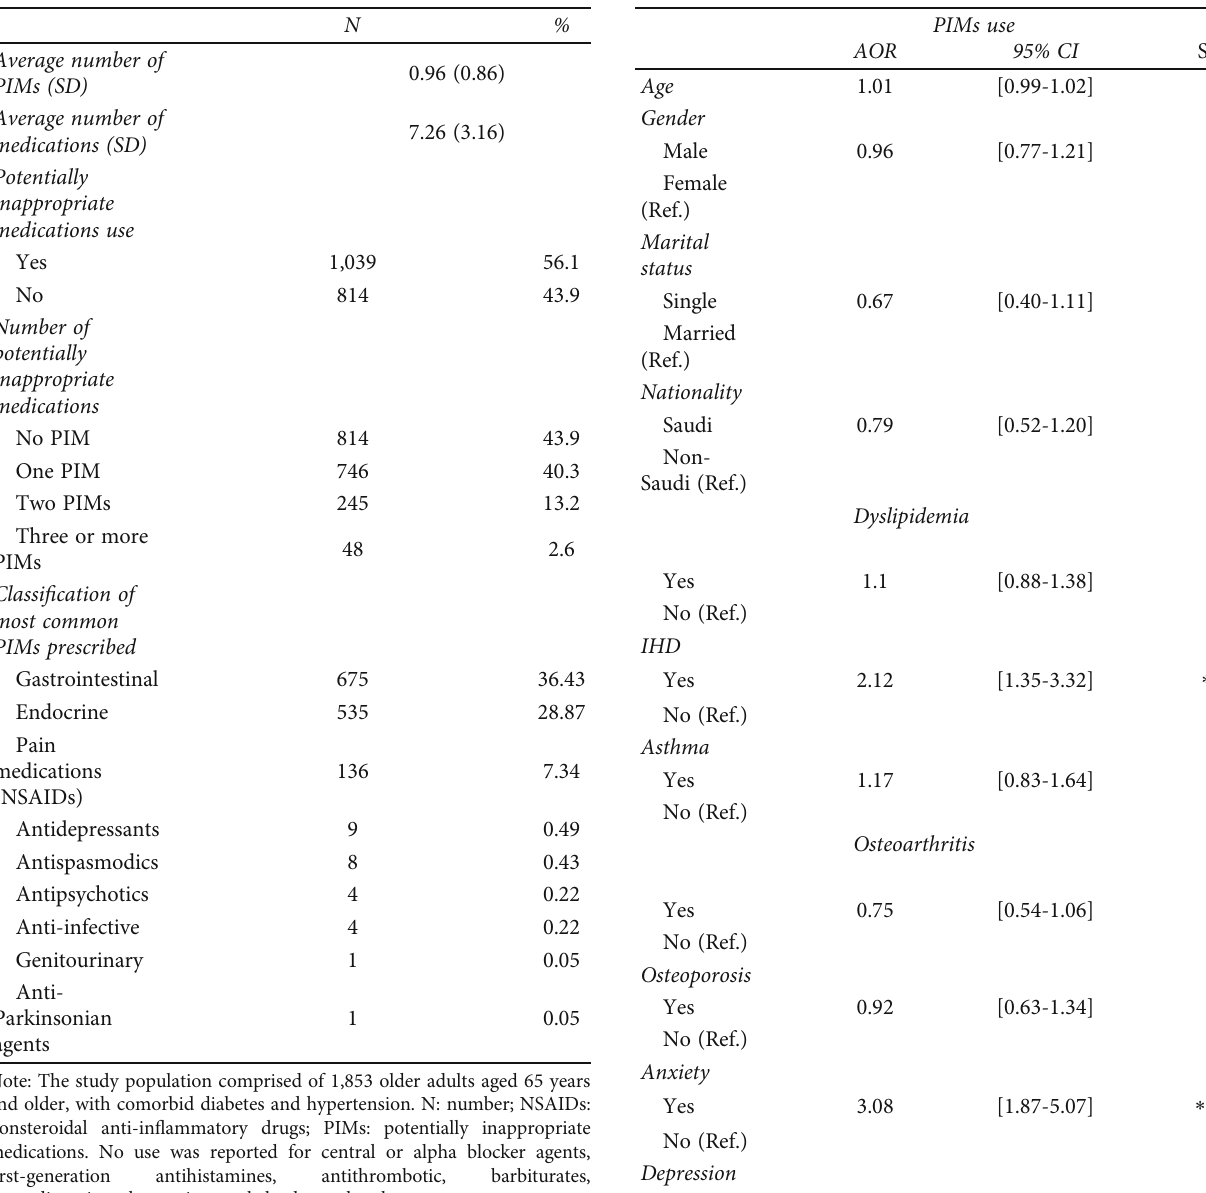
Table 2: Summary of the fi ndings of potentially inappropriate medications to be avoided for most older adults according to the 2019 Beers criteria.